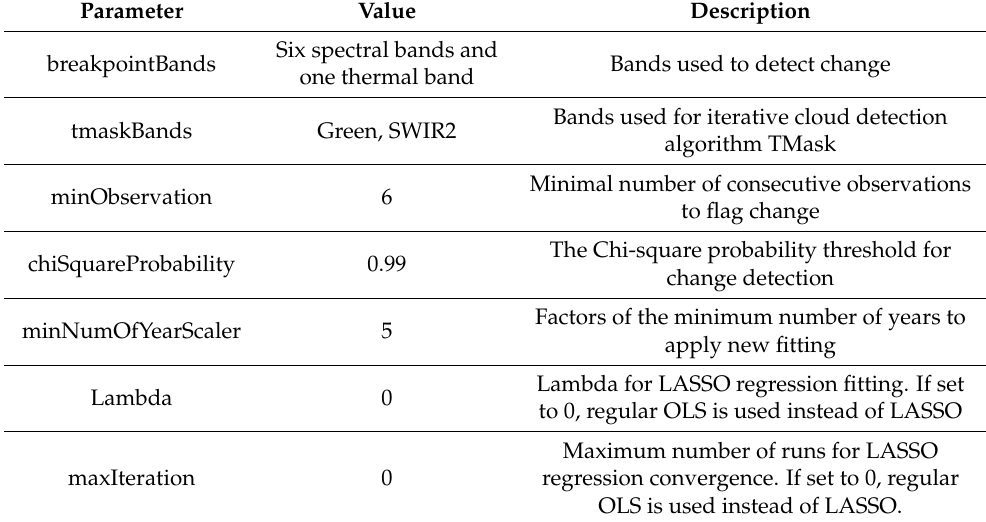
Table 2. The descriptions and values of parameters of CCDC. Parameter Value Description Six spectral bands and breakpointBands Bands used to detect change one thermal band Bands used for iterative cloud detection tmaskBands Green, SWIR2 algorithm TMask Minimal number of consecutive observations minObservation 6 to flag change The Chi-square probability threshold for chiSquareProbability 0.99 change detection Factors of the minimum number of years